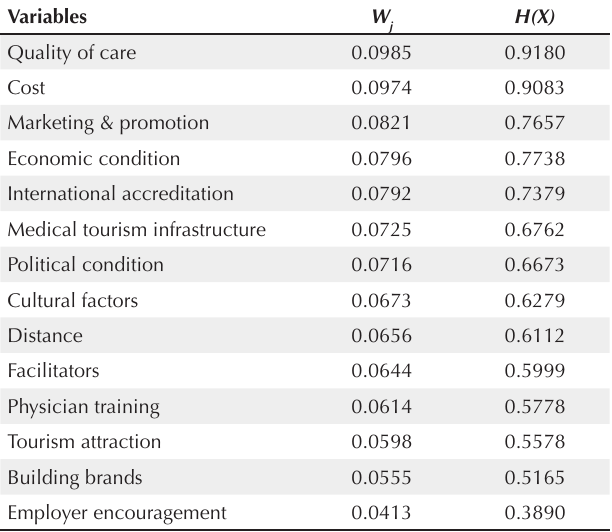
Table 2. The Calculated Importance Weight and the Marginal Entropy of the Influencing Factors